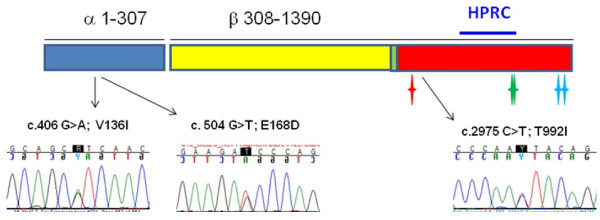
Location of mutations identified in MET oncogene. The MET protein is 1390 amino acids long (NM_000245.2, NP_000236.2). The pre-protein is cleaved into alpha and beta chains that are joined by a disulfide bond to create the extracellular receptor. The extracellular region (blue and yellow) contains a Sema domain, followed by a PSI and four IPT domains and are encoded in exons 2-12 of the mRNA. The transmembrane domain (green) is encoded in exon 13. The intracellular domain (red) is encoded in exons 14-21. Serine 985 (red star) down regulates kinase activity when phosphorylated, tyrosine 1234 and 1235 (green stars) positively modulate enzyme activity when phosphorylated, and tyrosine 1349 and 1356 (blue stars) recruit signal transducers when phosphorylated. Catalog of Somatic Mutations in Cancer (COSMIC) reports mutations in amino acids 130-370 of the extracellular domain, and 960-1340 of the intracellular tyrosine kinase domain. Amino acid changes responsible for Hereditary Papillary Renal Carcinoma (HPRC) are found between amino acids 1110 and 1268. Sequencing traces of the germline DNA mutations in the colon cancer sibling pair population are shown with their approximate location on the gene.